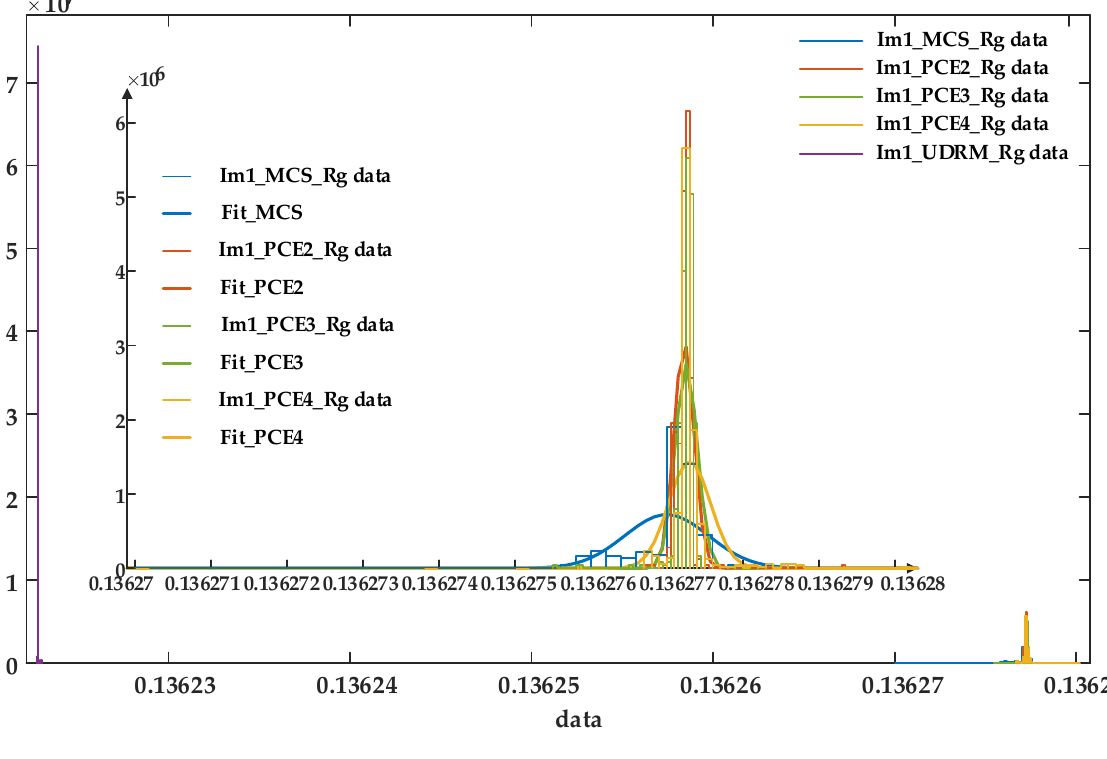
Figure 8. The probability density of the calculated data of I m1 using the 5 different methods under 50% uncertainty of grounding resistance under normal operation.